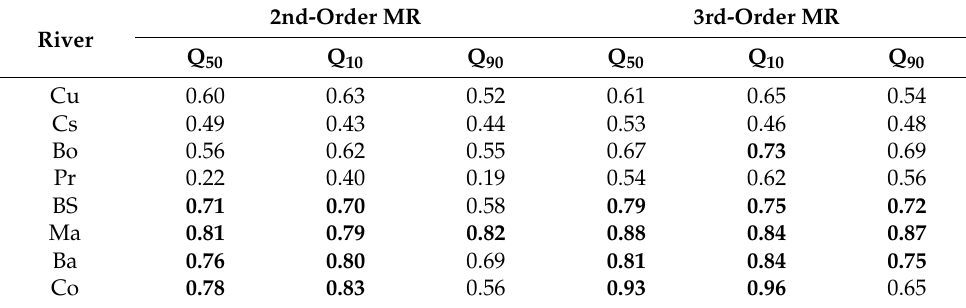
Table 5. Correlation coefficient ( R Pearson) between the observed and the predicted flow regimes by Niño 3.4 and DMI in SON a set. The values higher than 0.7 are bolded, indicating good model skill.